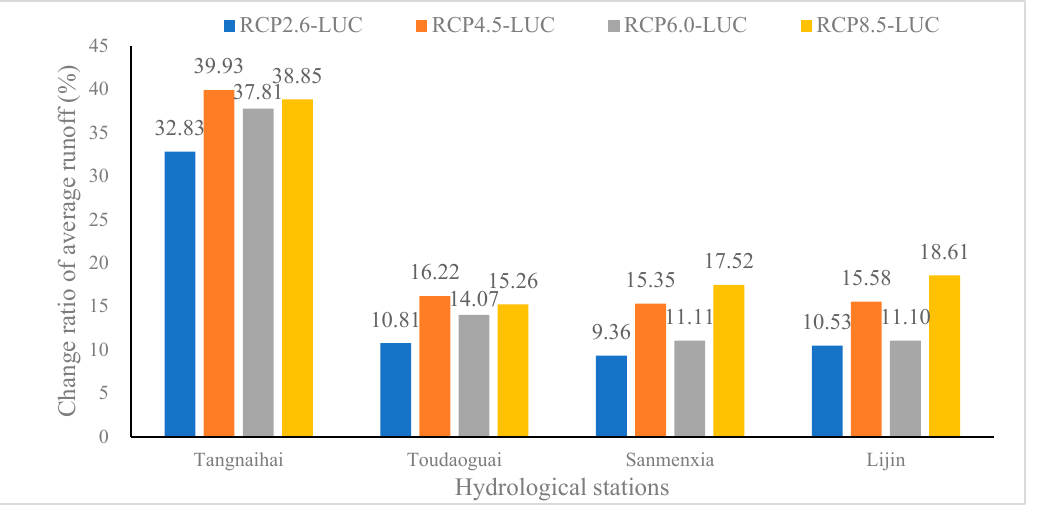
Figure 12. The differences between the average runoff in the future period and the base period of the four hydrological stations.